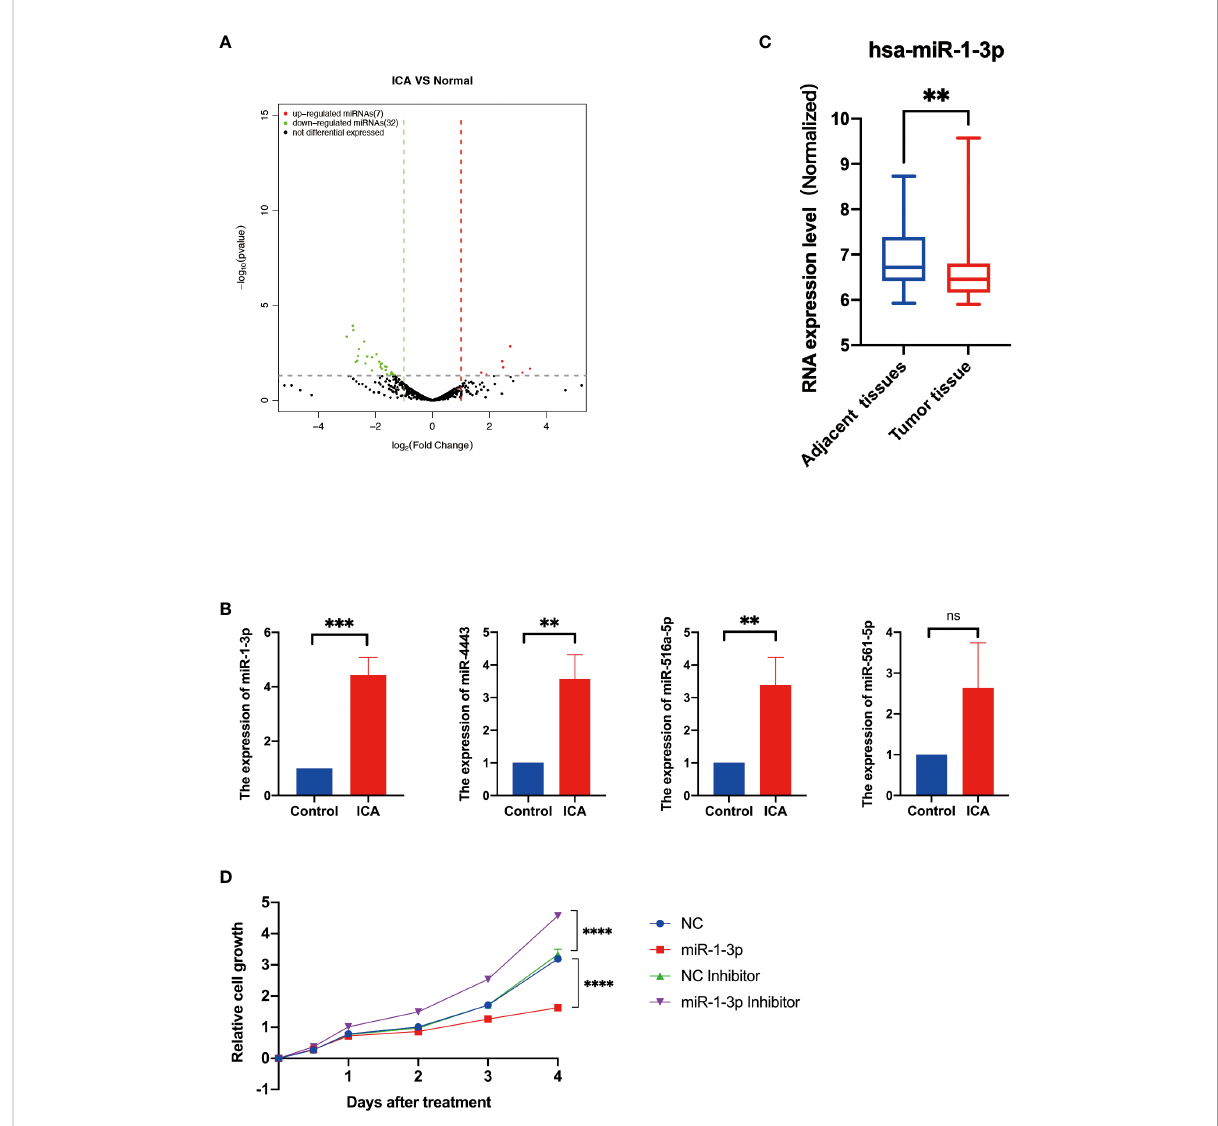
FIGURE 2 Icariin upregulates the expression of miR-1-3p in SKOV-3 cells. (A) The volcano plot of miRNAs with differential expression. The DESeq2 program was used to evaluate changes in gene expression using a t test. Green (downregulated) and red (upregulated) dots indicate the 39 signi fi cant differentially expressed miRNAs. (B) RT – qPCR analysis of miR-516-5p, miR-4443, miR-516a-5p, and miR-1-3p expression in the SKOV-3 cells after icariin treatment. (n=3 per group). (C) Expression analysis of miR-1-3p in adjacent normal tissues and ovarian cancer tissues from Gene Expression Omnibus Database (GSE31801, n=121), **p<0.01. (D) Growth curves of SKOV-3 cells transfected with indicated miRNAs. Data were shown with mean±SD (n=3), ns P > 0.05, **p<0.01, ***p<0.001,